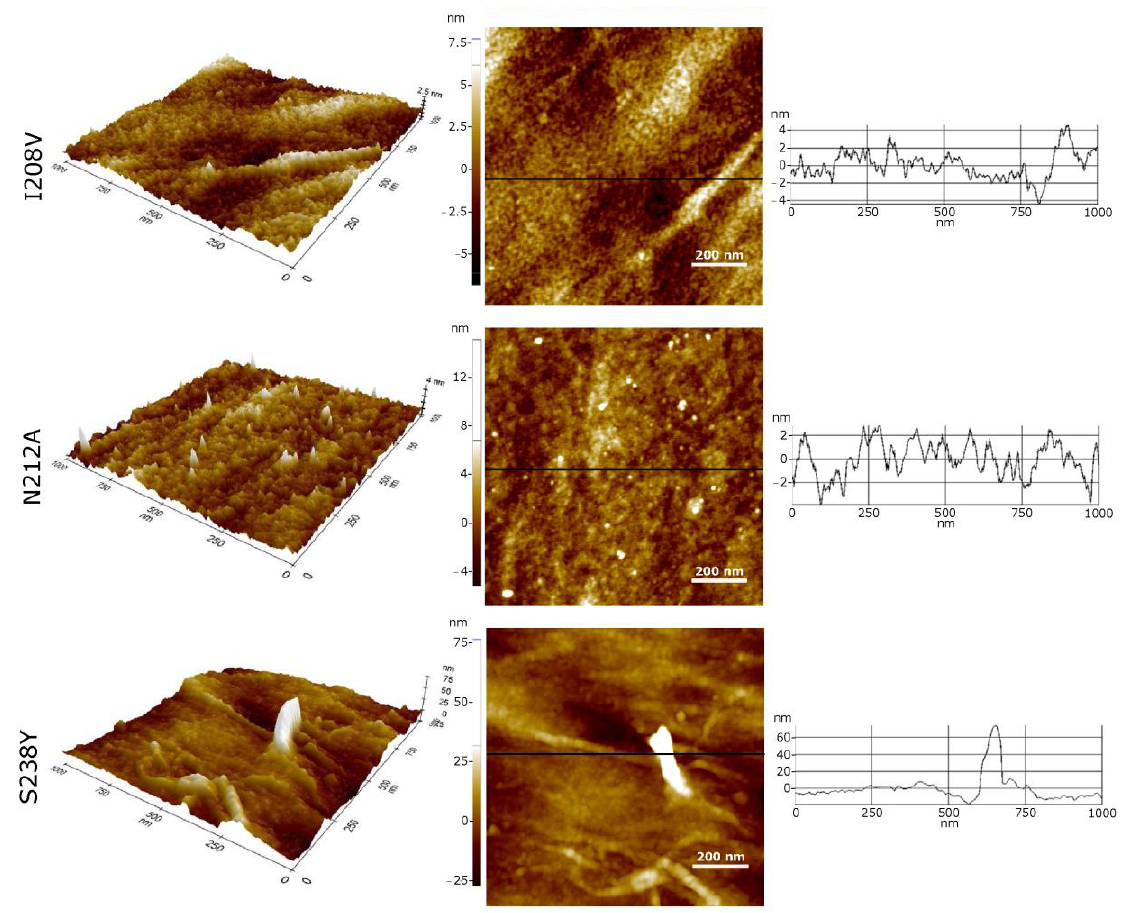
Figure 4. AFM surface topographic 3D and 2D characterizations of PET films degraded by Is PETase WT and mutant variants. The profiles extracted from the depicted solid lines reveal the height dif- ferences.